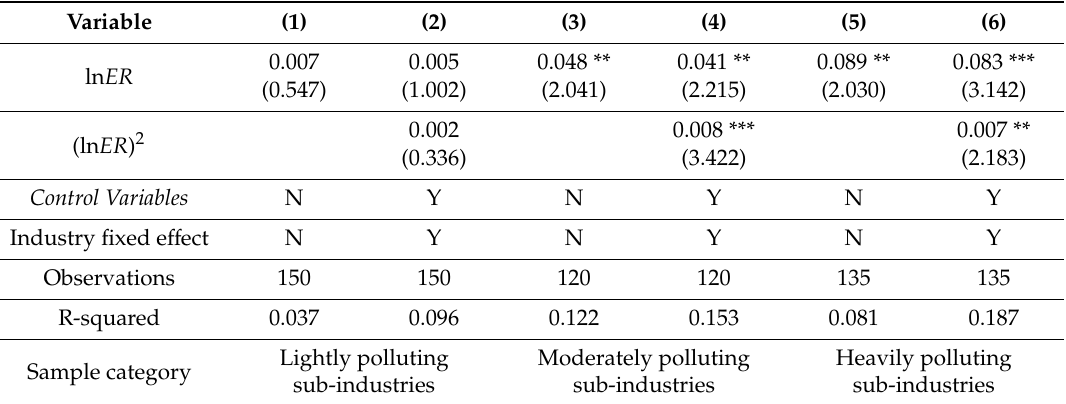
Table 3. Estimated outcomes according to